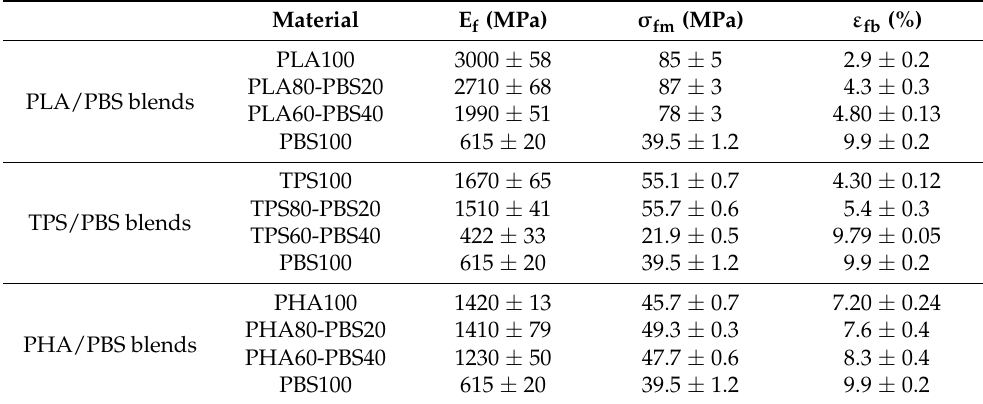
Table 7. Flexural test results of PLA/PBS